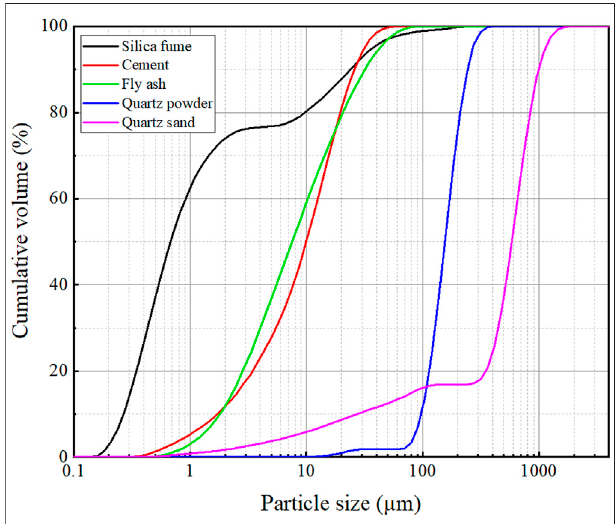
FIGURE1| Particlesizedistributionsofrawmaterialsmeasured bylaser